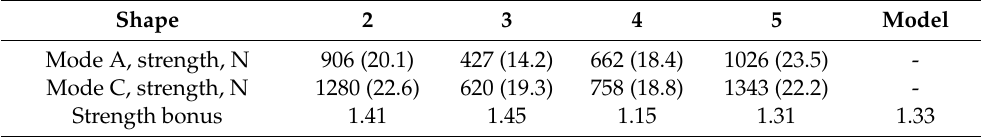
Table 5. Strengthening of parts by lowering the layer height (with transition from mode A to mode C).